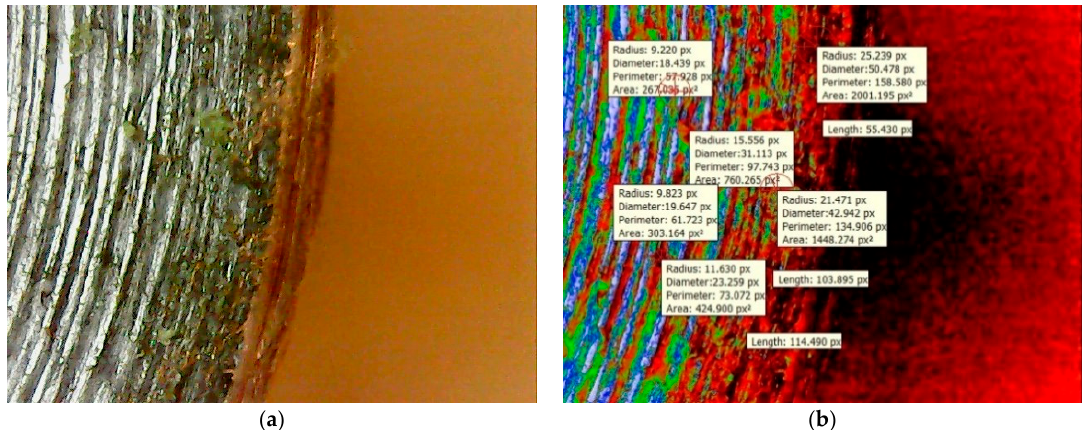
Figure 16. ( a ) Al-Cu welded interface at the edge. ( b ) Segment based analysis of the crack length.